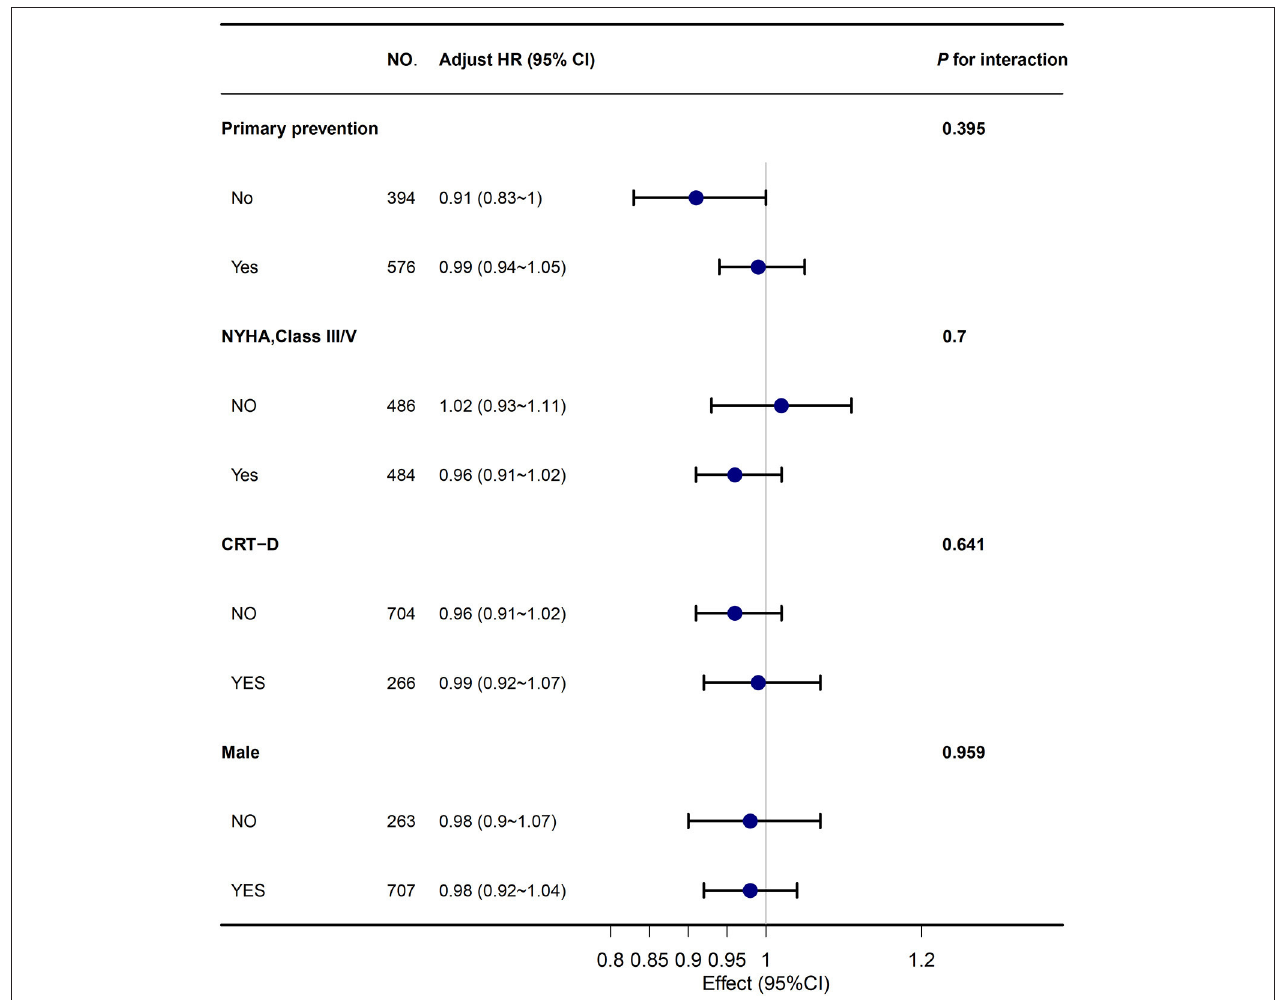
FIGURE 3 | The association between BMI and all-cause mortality in subgroups. Abbreviations are shown in Table 1 .